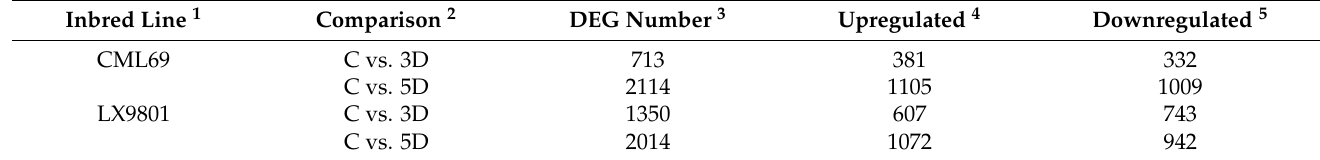
Table 3. Expression of the 2219 common drought-responsive DEGs by inbred line and drought stress stage. Inbred Line